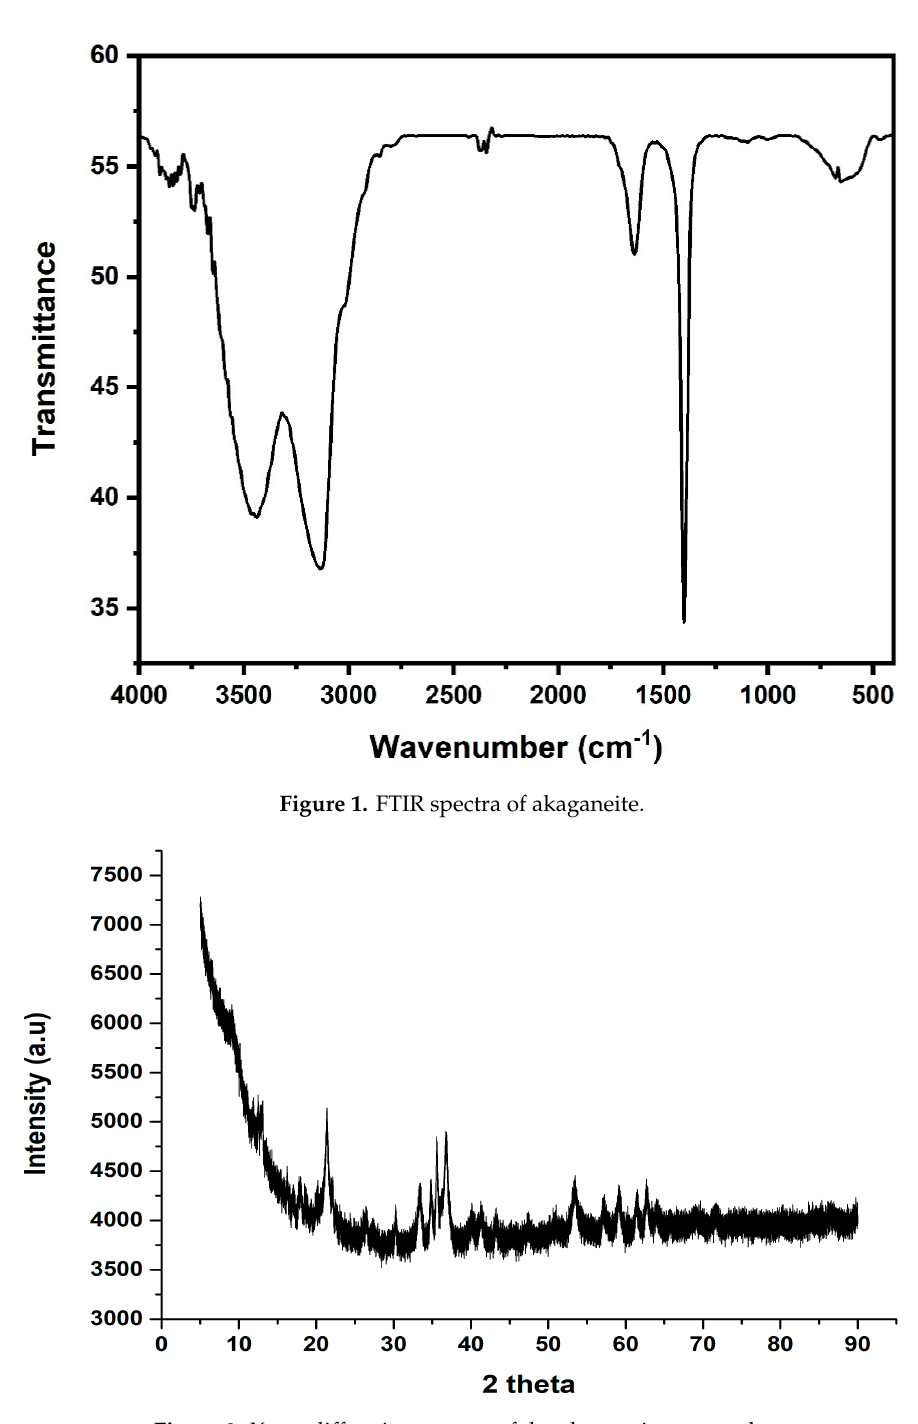
Figure 2. X-ray diffraction pattern of the akaganeite nanorods. Figure 2. X-ray di ff raction pattern of the akaganeite